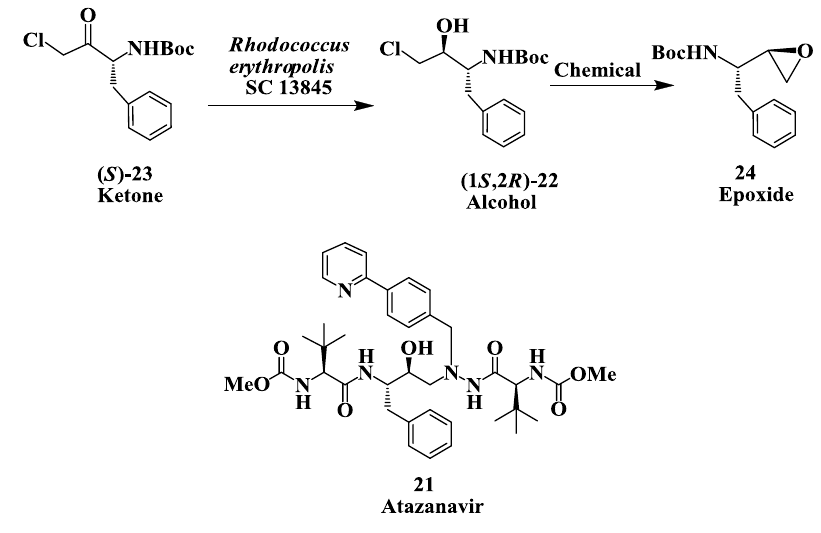
Figure 6. Atazanavir (antiviral agent): Enzymatic reparation of (1 S ,2 R )-[3-chloro-2- hydroxy-1-(phenylmethyl) propyl]-carbamic acid,1,1-dimethyl-ethyl ester.